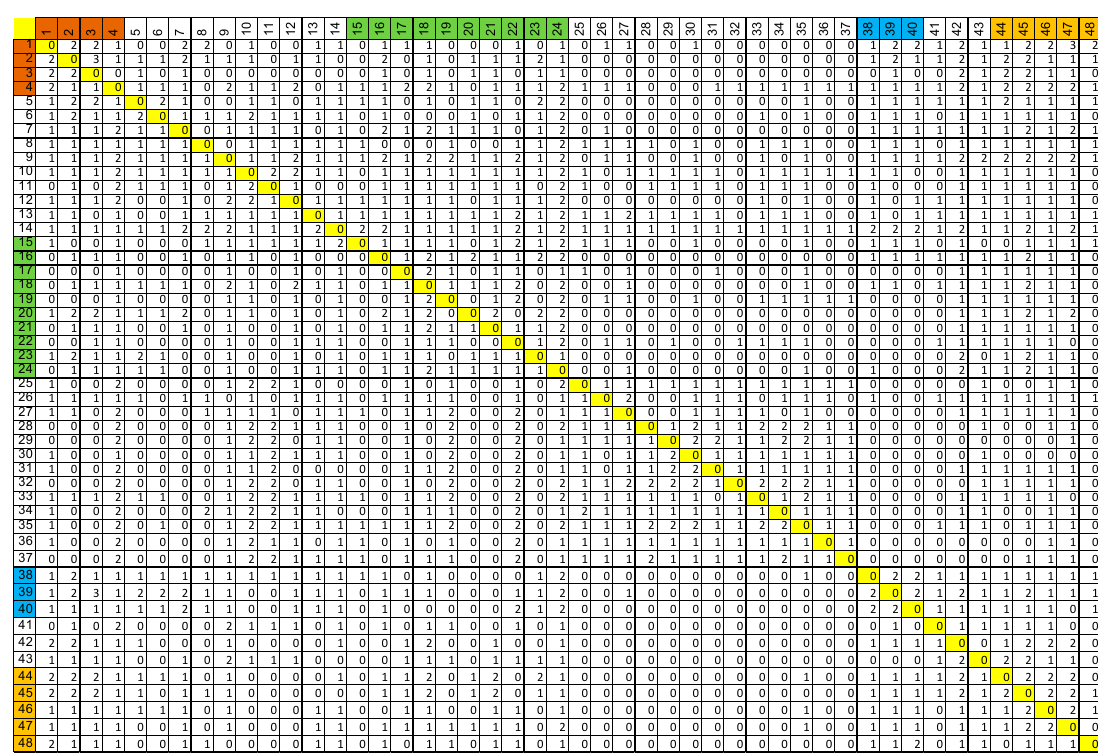
Figure 3. The average values of influences (numbers of rows and columns—the coloured areas correspond to the description of the variable; see Table 1). Table 1. List of important variables indicated by the expert group for CO 2 -EGS technology.